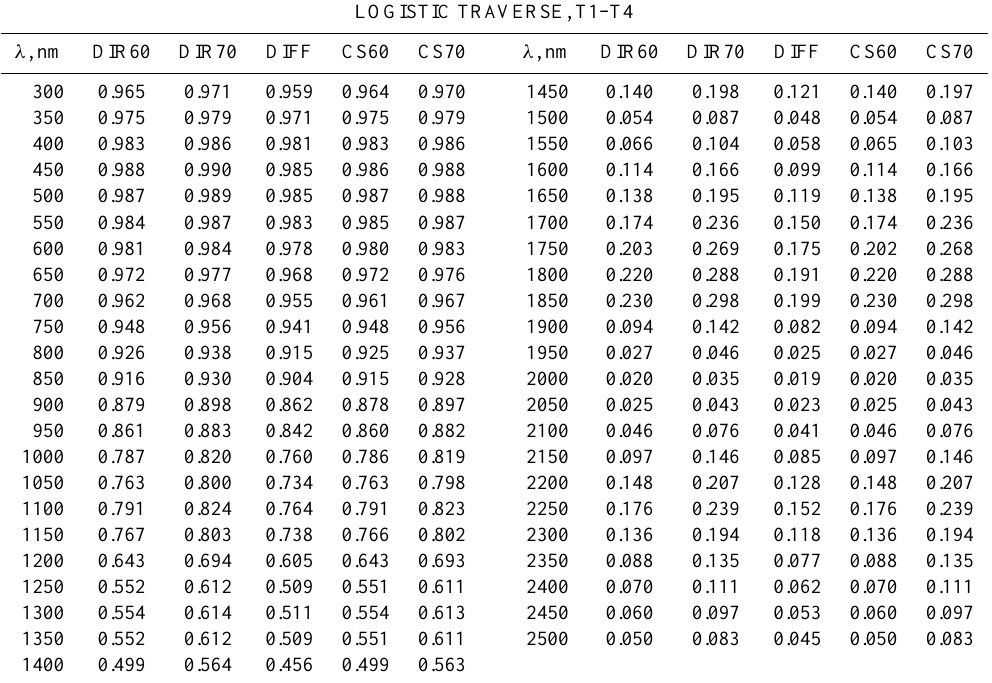
Table A4. Directional hemispherical reflectance of the mean of pits T1 to T4, calculated using the light sources of Table 2. LOGISTIC TRAVERSE,